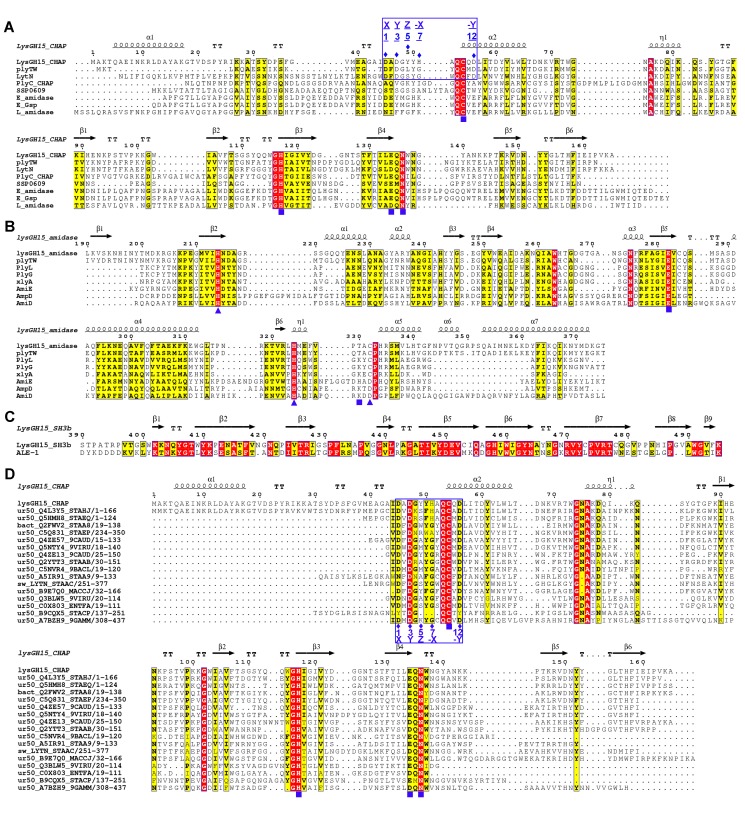
Sequence alignment of the three individual LysGH15 domains and homologous proteins.(A) The CHAP domain. The 12-residue calcium-binding site is indicated by a blue box. The Cys-His-Glu-Asn quartet and the calcium-binding residues (conserved positions 1, 3 5, 7, and 12) are indicated by filled blue squares and filled blue diamonds, respectively. (B) The amidase-2 domain. The zinc-binding residues of this domain are indicated by filled blue triangles, and the catalytic residues are indicated by filled blue squares. (C) The SH3b domain. (D) Sequence alignment of the CHAP domain with several members of the CHAP family from the Pfam database. The accession number of this family in the Pfam database is PF05257 (http://pfam.sanger.ac.uk/family/PF05257). The Cys-His-Glu-Asn quartet residues are indicated by filled blue squares. The 12-residue calcium-binding site is indicated by a blue box, and the positions 1, 3, 5, 7, and 12 (filled blue diamonds) are indicated by X, Y, Z, –X, and –Y, respectively. All alignments were generated using CLUSTAL W (http://www.ch.embnet.org/software/ClustalW.html). The figure was generated using ESPript (http://espript.ibcp.fr/ESPript/ESPript/index.php). Strictly conserved residues are boxed in white on a red background, and highly conserved residues are boxed in black on a yellow background. A schematic representation of the secondary structure elements of the corresponding structures are shown above the sequences.